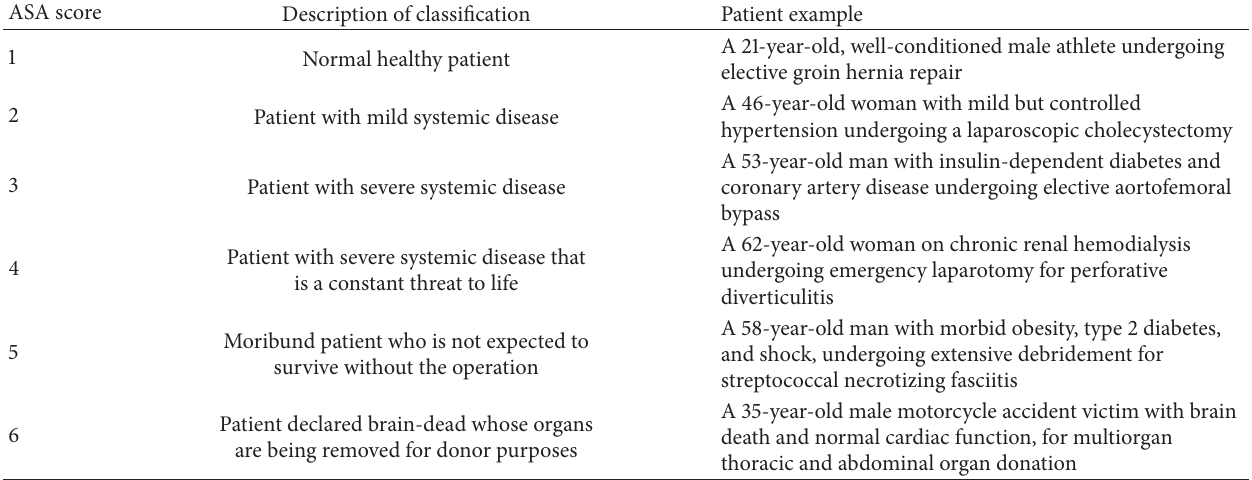
Table 3: Descriptor of the six categories that currently comprise the American Society of Anesthesiology Physical Status Classification System ∗